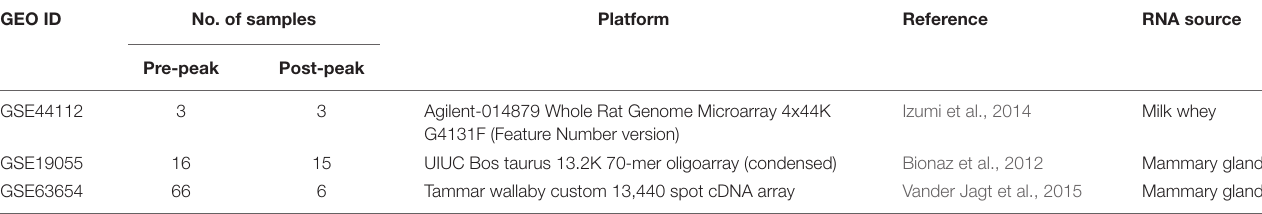
TABLE 1 | The original datasets selected for meta-analysis of milk